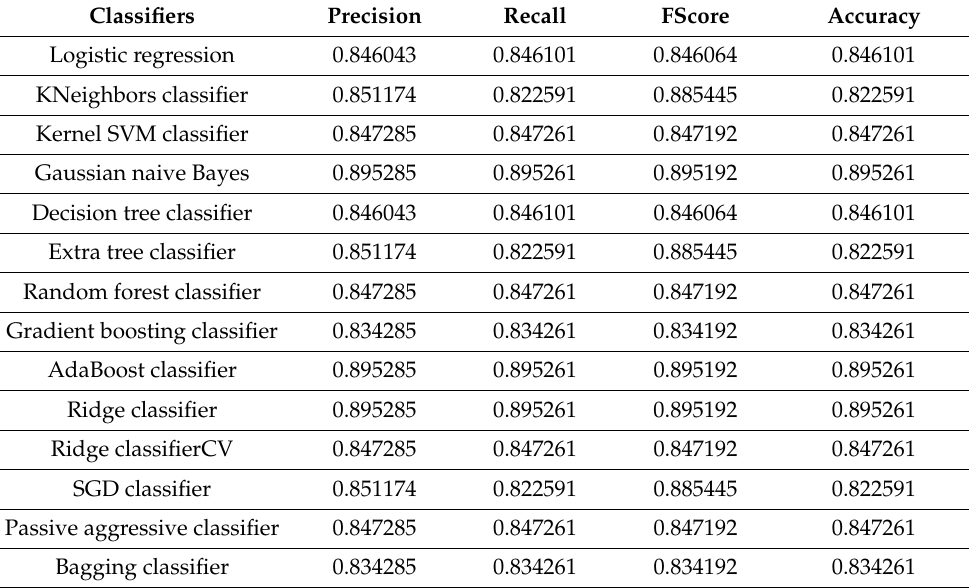
Table 16. Random forest regressor metrics after feature scaling.